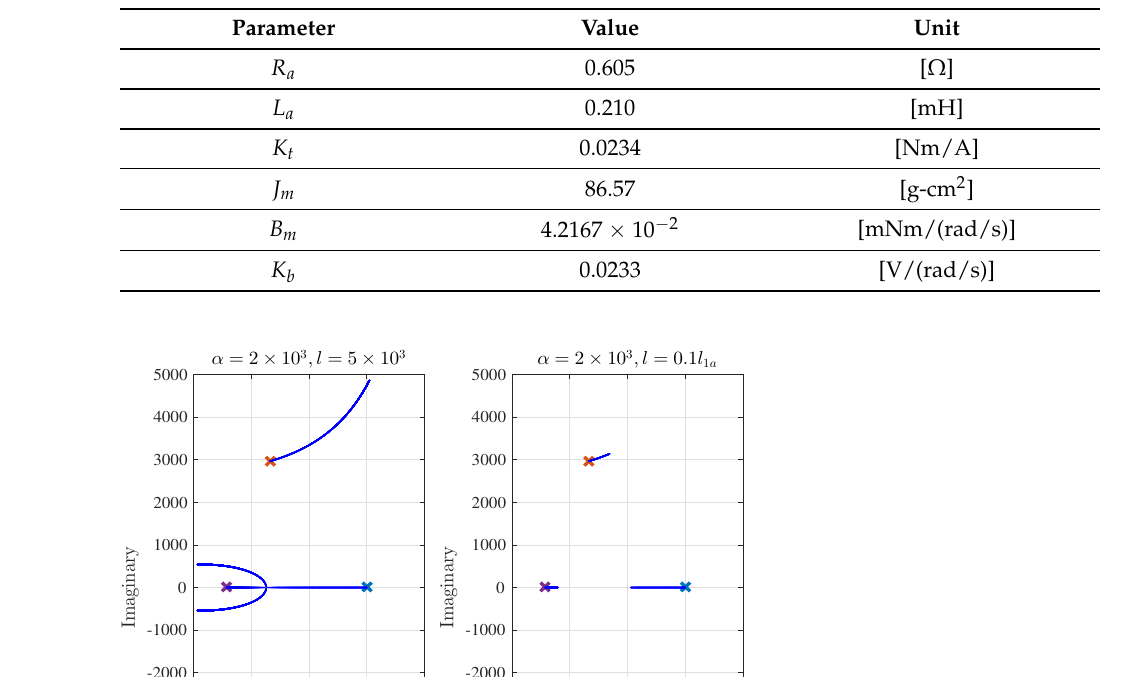
Table 1. DC Motor System Parameters [12].